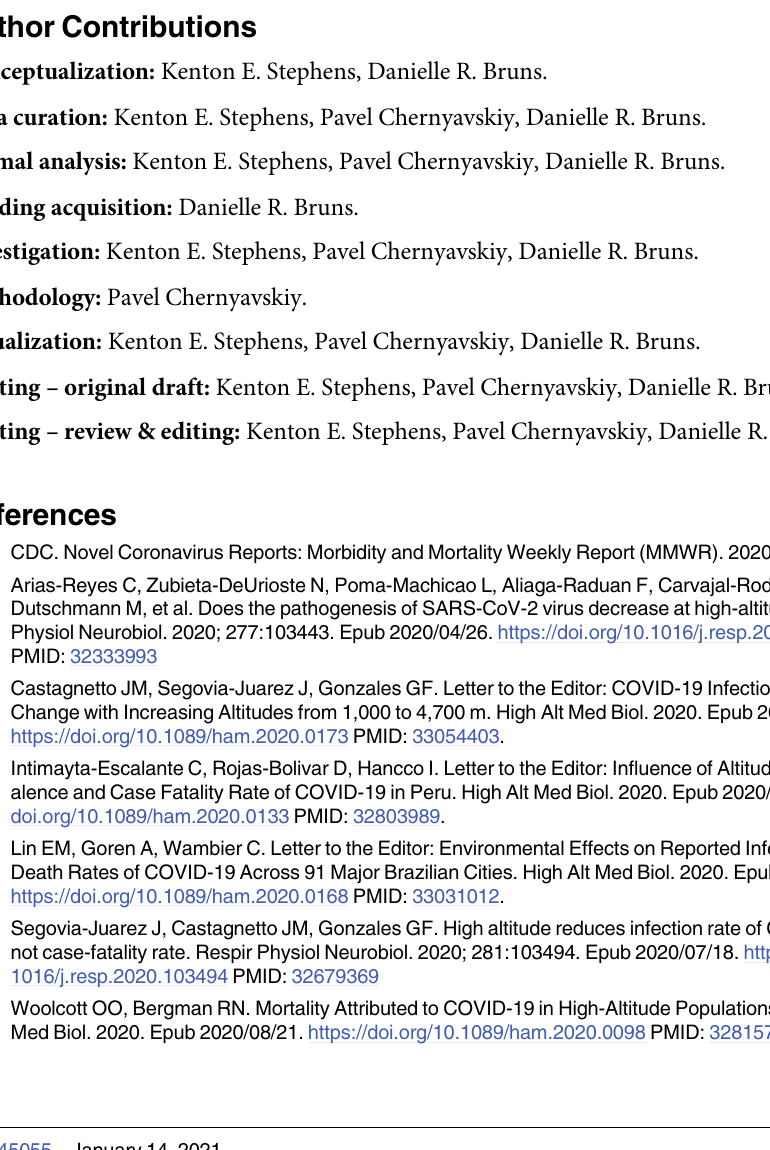
S1 Table. Akaike Information Criterion (AIC) and percent deviance explained in paren- theses for the statistical models considered. Smaller AIC and larger percent deviance explained constitutes the preferred